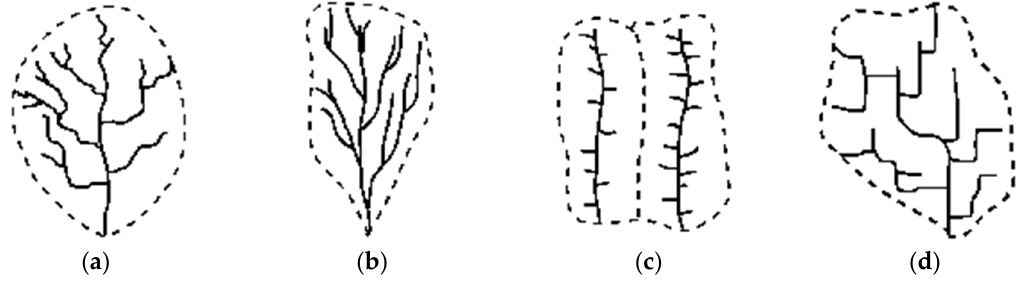
Figure 1. Drainage patterns. ( a ) is an illustration of dendritic pattern, ( b ) is a parallel pattern, ( c ) is a trellis pattern and ( d ) is rectangular pattern.